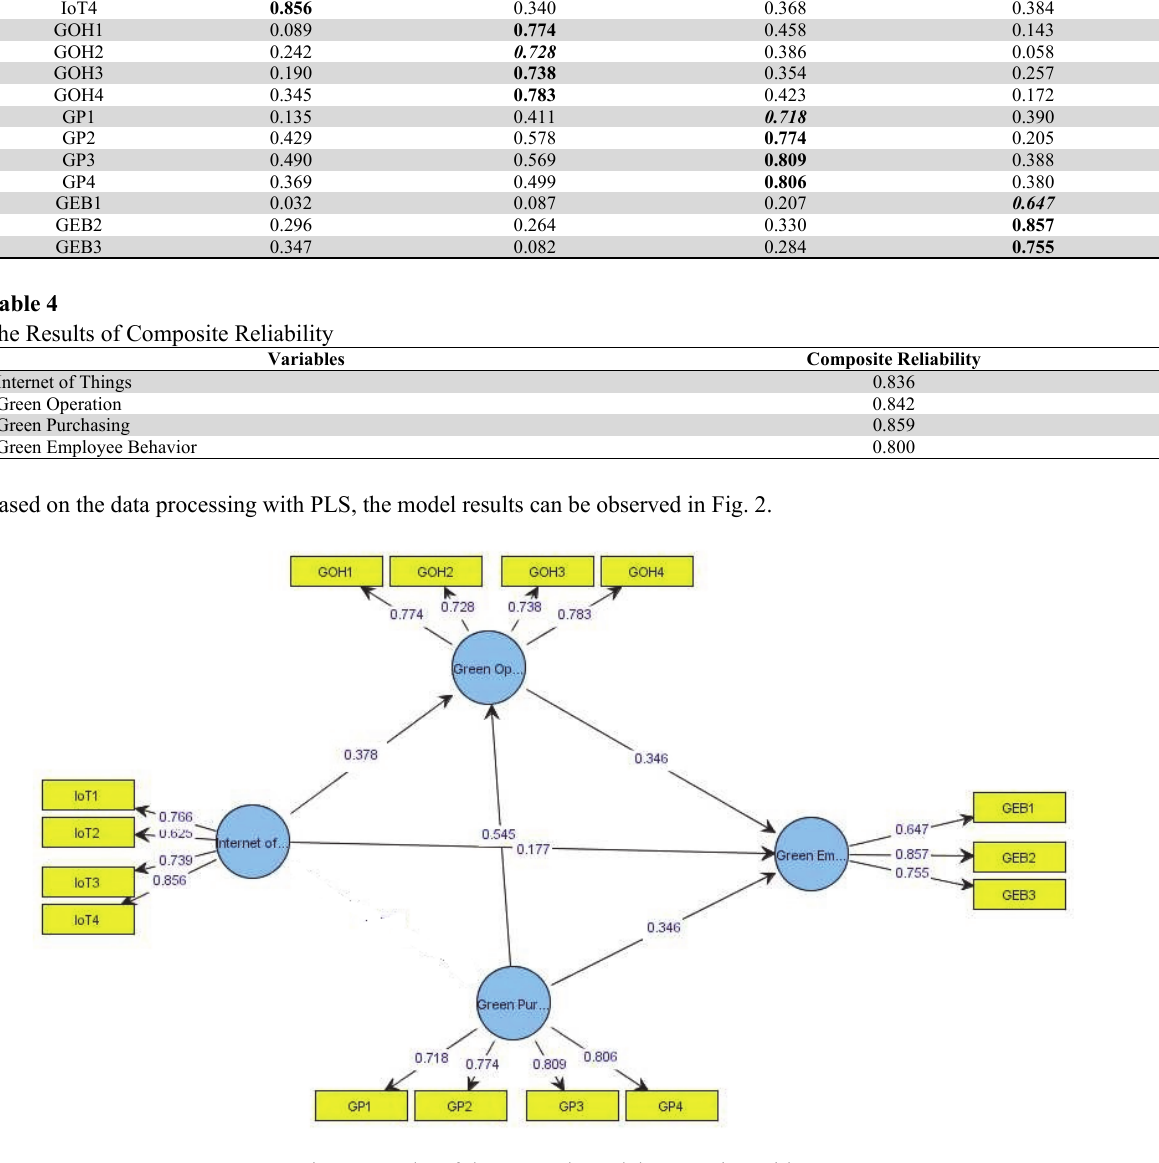
The results of convergent validity with cross-loading Indicators